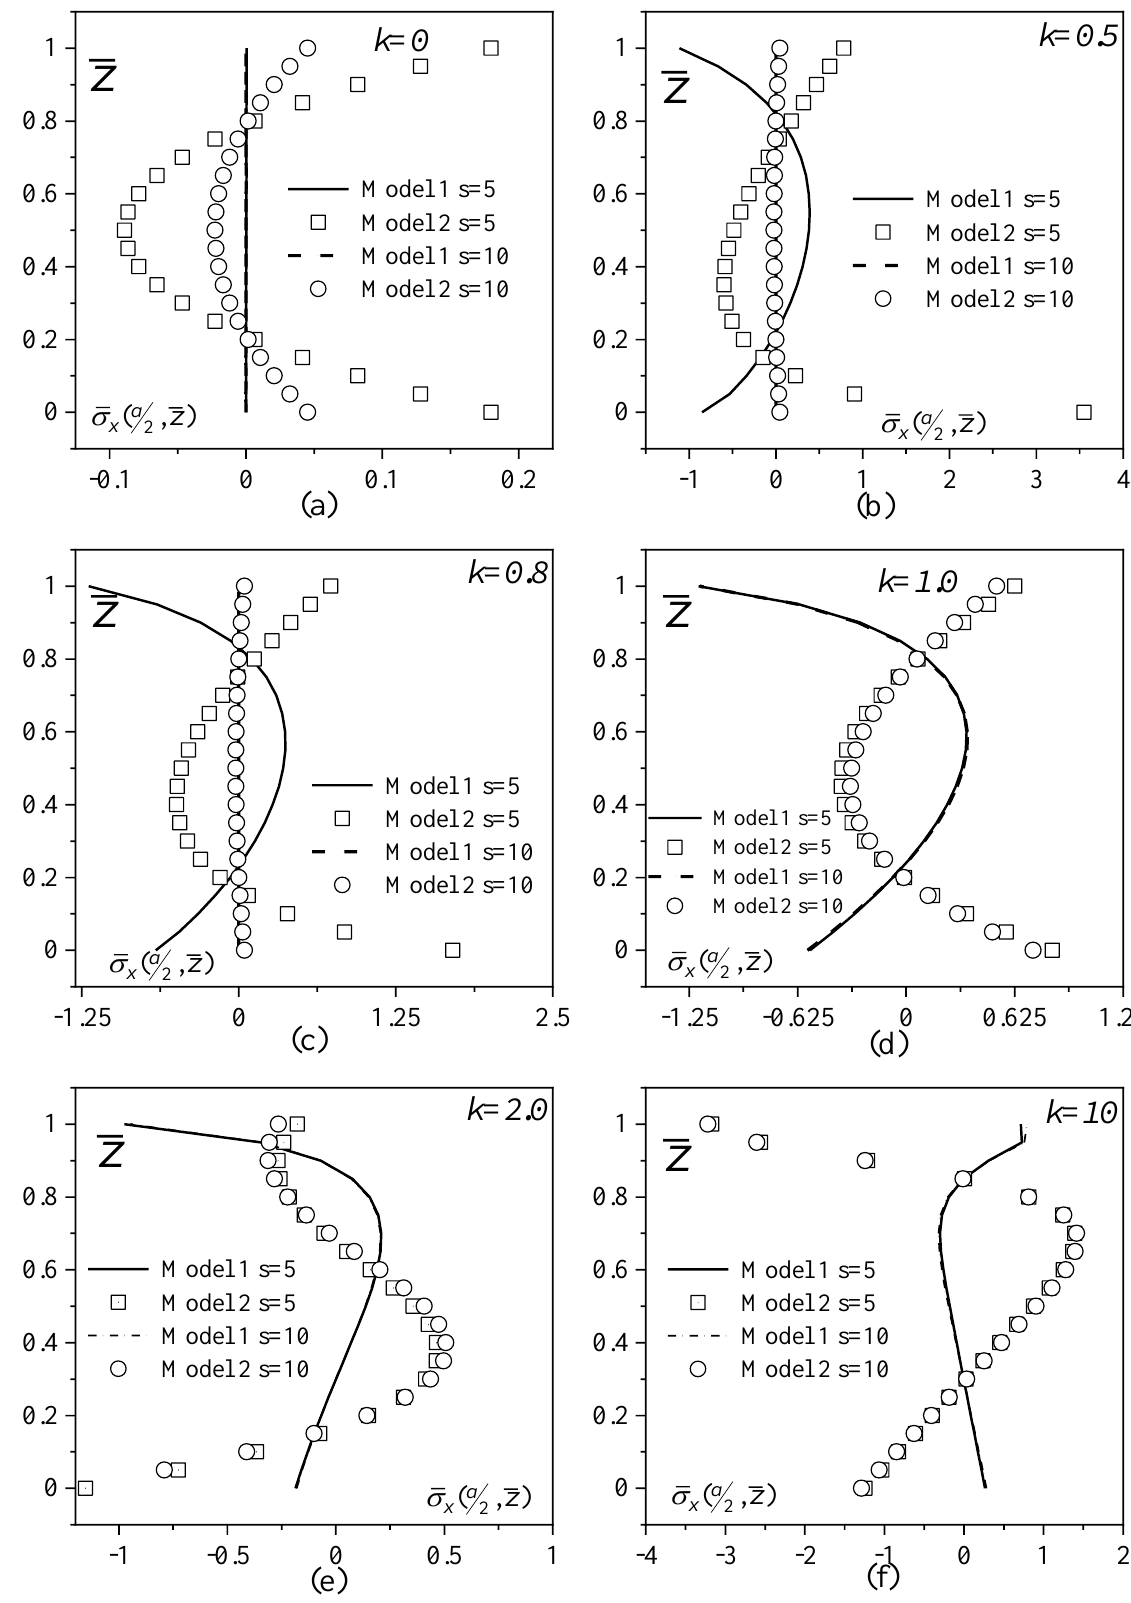
Fig. 7. Thickness variation of normalized in-plane stresses (